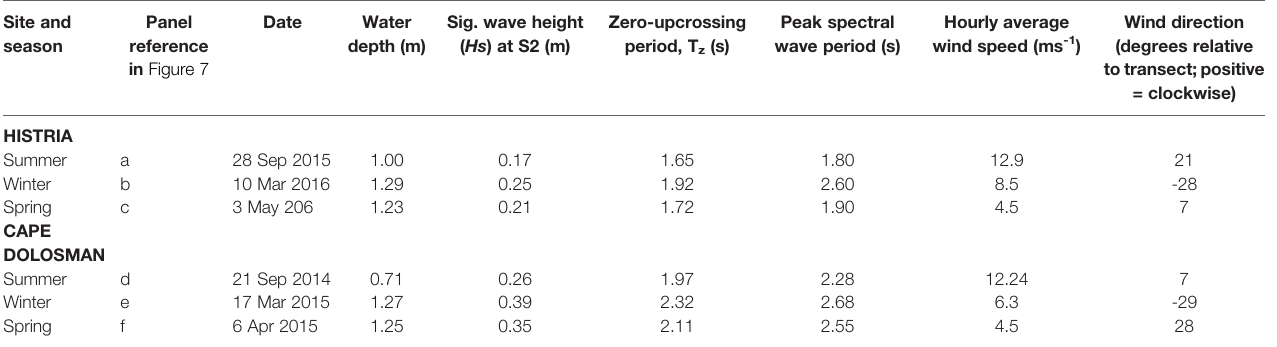
TABLE 3 | Incident water depth wind speed, direction, zero-upcrossing and peak wave periods during the most energetic wave conditions in each season recorded at Cape Dolosman (CD) and Histria (HS)